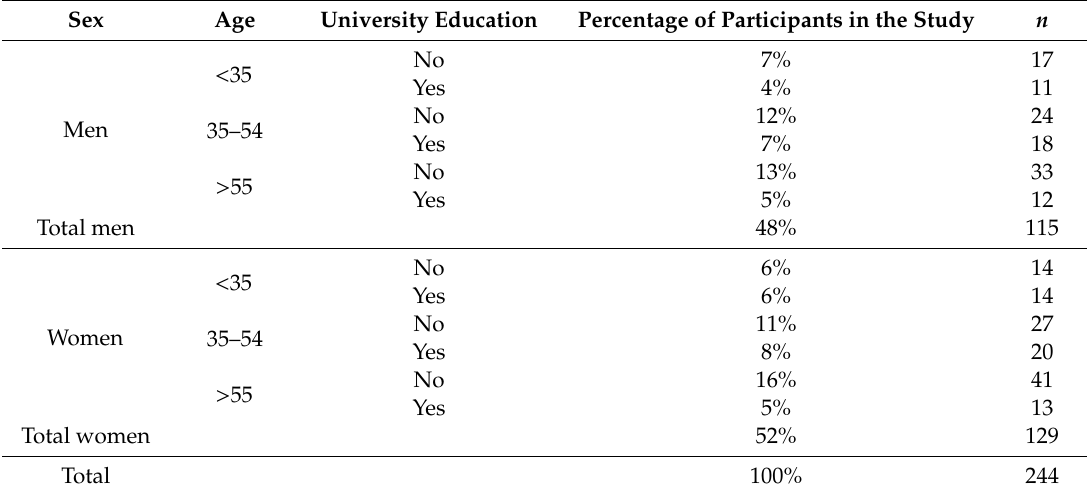
Table 1. Sample distribution by sex, age, and educational